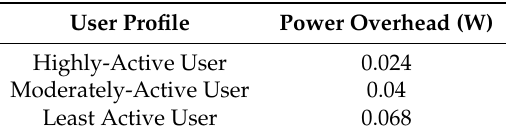
Table 3. Power overhead of different